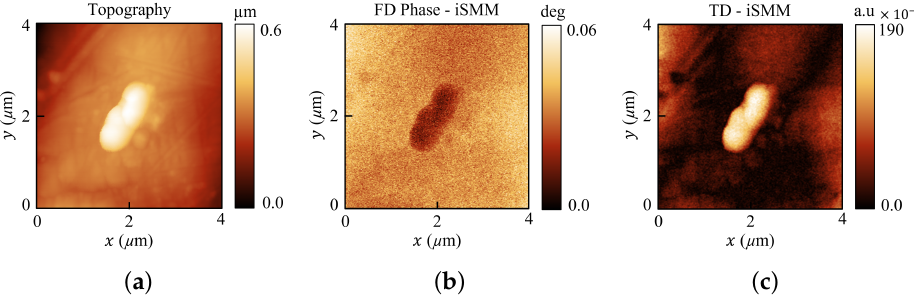
Figure 5. iSMM images of a nanocomposite particle. ( a ) AFM topography. ( b ) Frequency domain phase signal image of iSMM recorded at a frequency of 5.99 GHz. ( c ) iSMM time domain